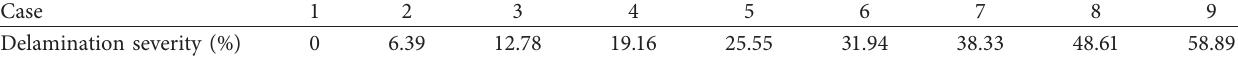
Figure 9: Perimeter sealant failure illustration of different cases: (a) Case 1; (b) Case 2; (c) Case 3; (d) Case 4; (e) Case 5; (f) Case 6; (g) Case 7; (h) Case 8; (i) Case 9. Table 2: Delamination level.